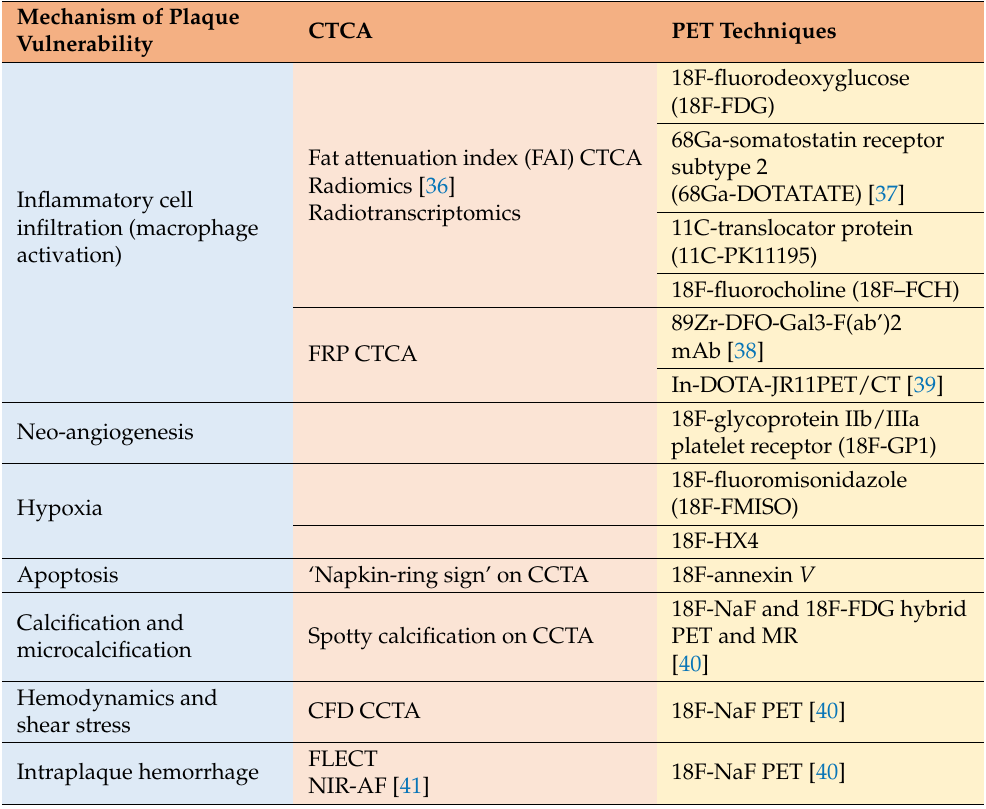
Table 1. Non-invasive imaging of vulnerable plaque classified by the mechanisms of